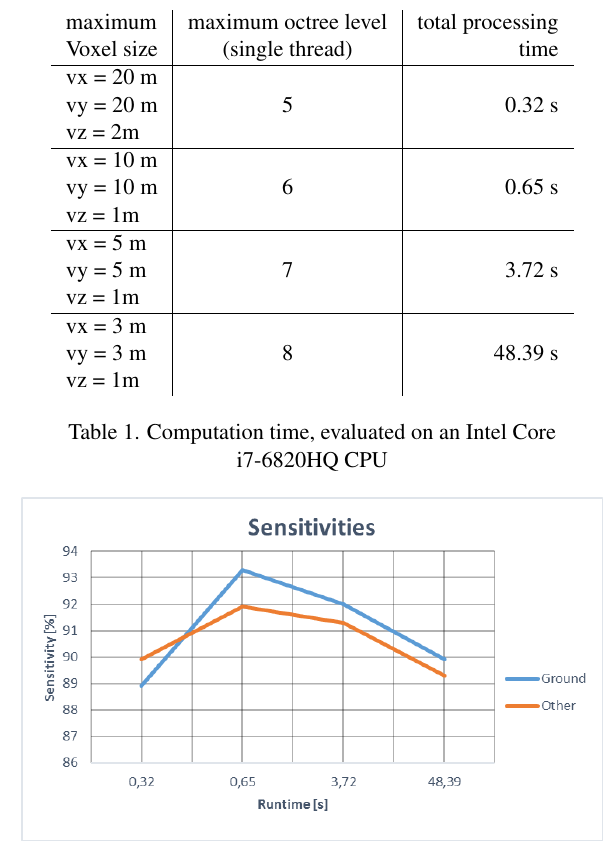
Figure 8. Sensitivity, dependent on the runtime. Different Voxel sizes are symbolized by different run times.